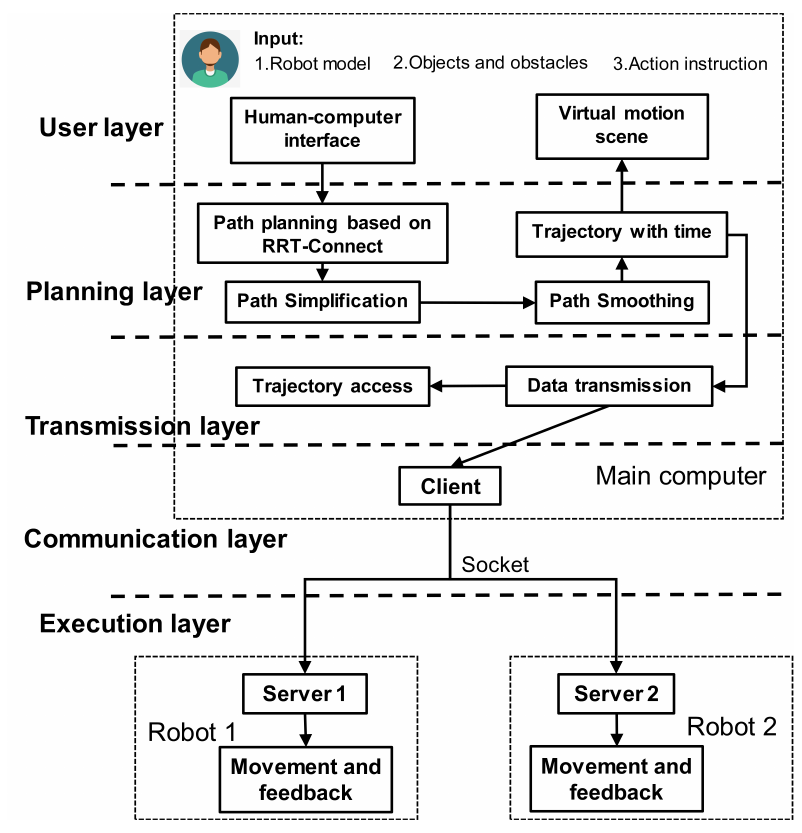
Figure 2. Dual-robot collaborative trajectory planning hierarchy.